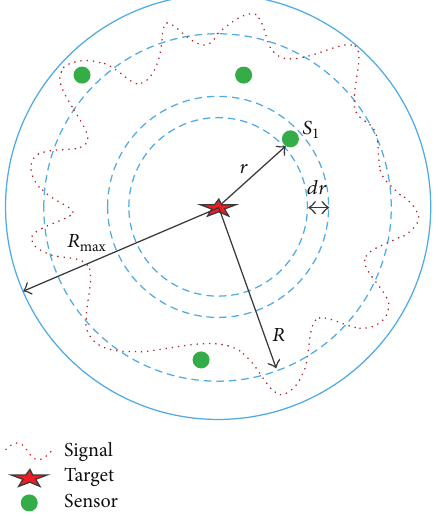
Figure 2: Sensing area for coverage probability